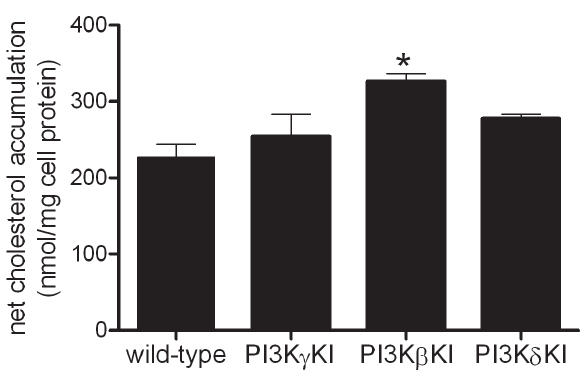
Figure 6. LDL-derived cholesterol accumulation occurs in- dependently of class I PI3K isoforms. Cholesterol accumulation after 24 h-incubation without or with 1 mg/ml LDL was assessed in M- CSF differentiated macrophages cultured from wild-type, PI3K c -KI, PI3K b -KI, and PI3K d -KI